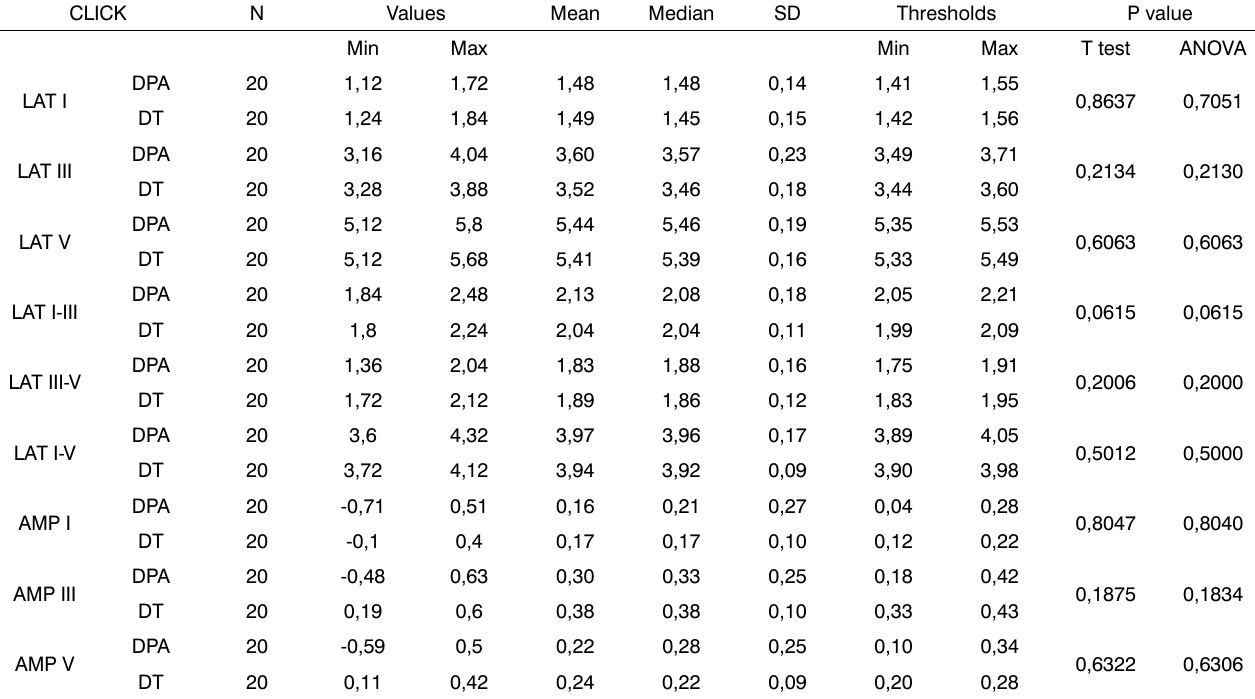
Table 1. Click stimulus - minimum, maximum, mean, medians, standard deviation (SD), confidence interval and latency p values of the laten- cies, amplitudes and interpeak intervals in both groups.